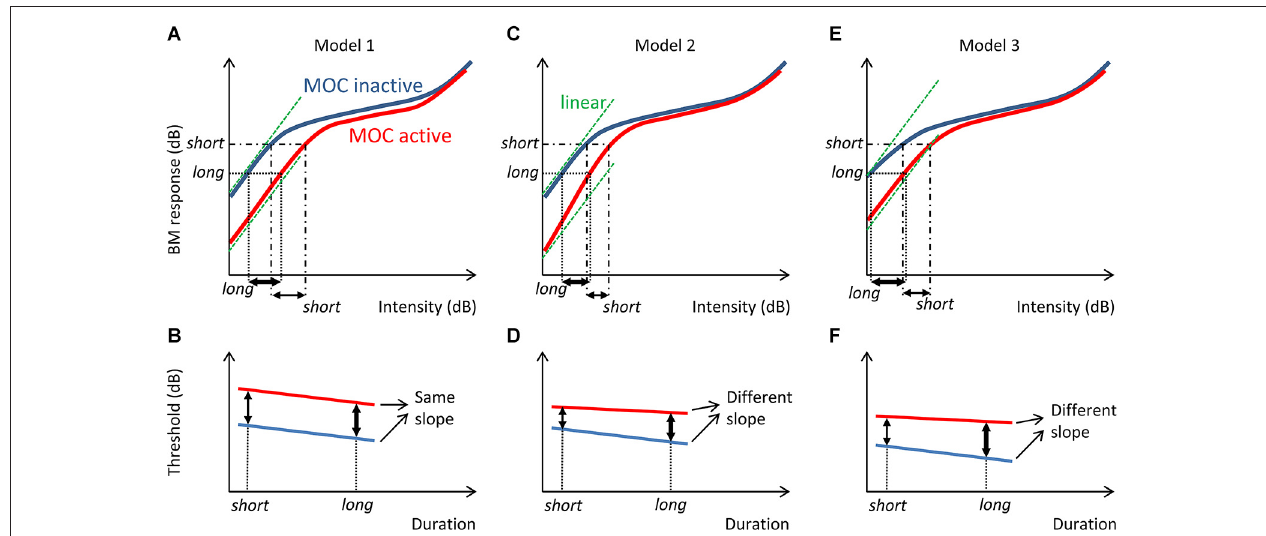
input threshold levels (C) . In other words, in this case MOC activation would turn a linear BM input/output function near threshold into expansive (slope > 1 dB/dB). In this case, MOC activation would vertically shift the threshold-vs.-duration function with a concomitant change in slope (D) . The right panels illustrate a third model (Model 3) where BM responses are slightly compressive (slope < 1 dB/dB) at threshold and MOC activation suppresses BM responses more at low than at moderate input levels in the threshold range, thus causing the compressive BM input/output curve to become linear near threshold (E) . In this case, MOC activation would also vertically shift the threshold-vs.-duration function with a concomitant change in slope (F) . For reference, the green dashed lines illustrate hypothetical linear input/output